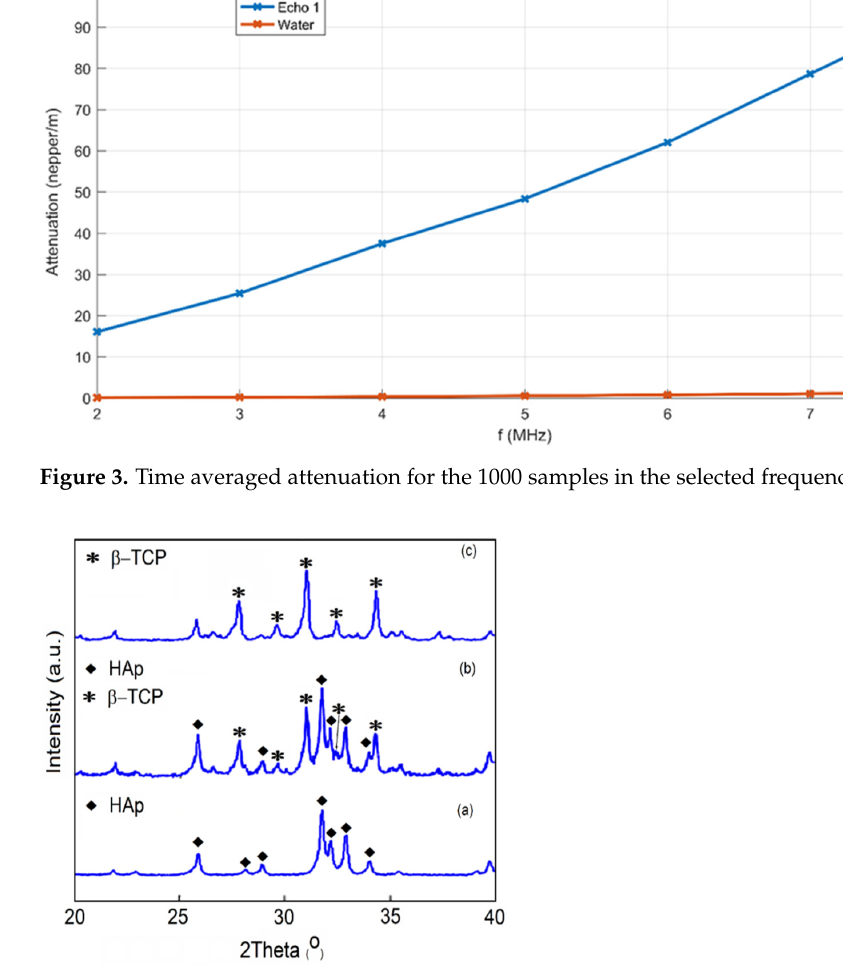
Figure 4. XRD patterns of 10 MgHApCh-0 ( a ), 10 MgHApCh-3 ( b ) and 10 MgHApCh-6 ( c ) sam-